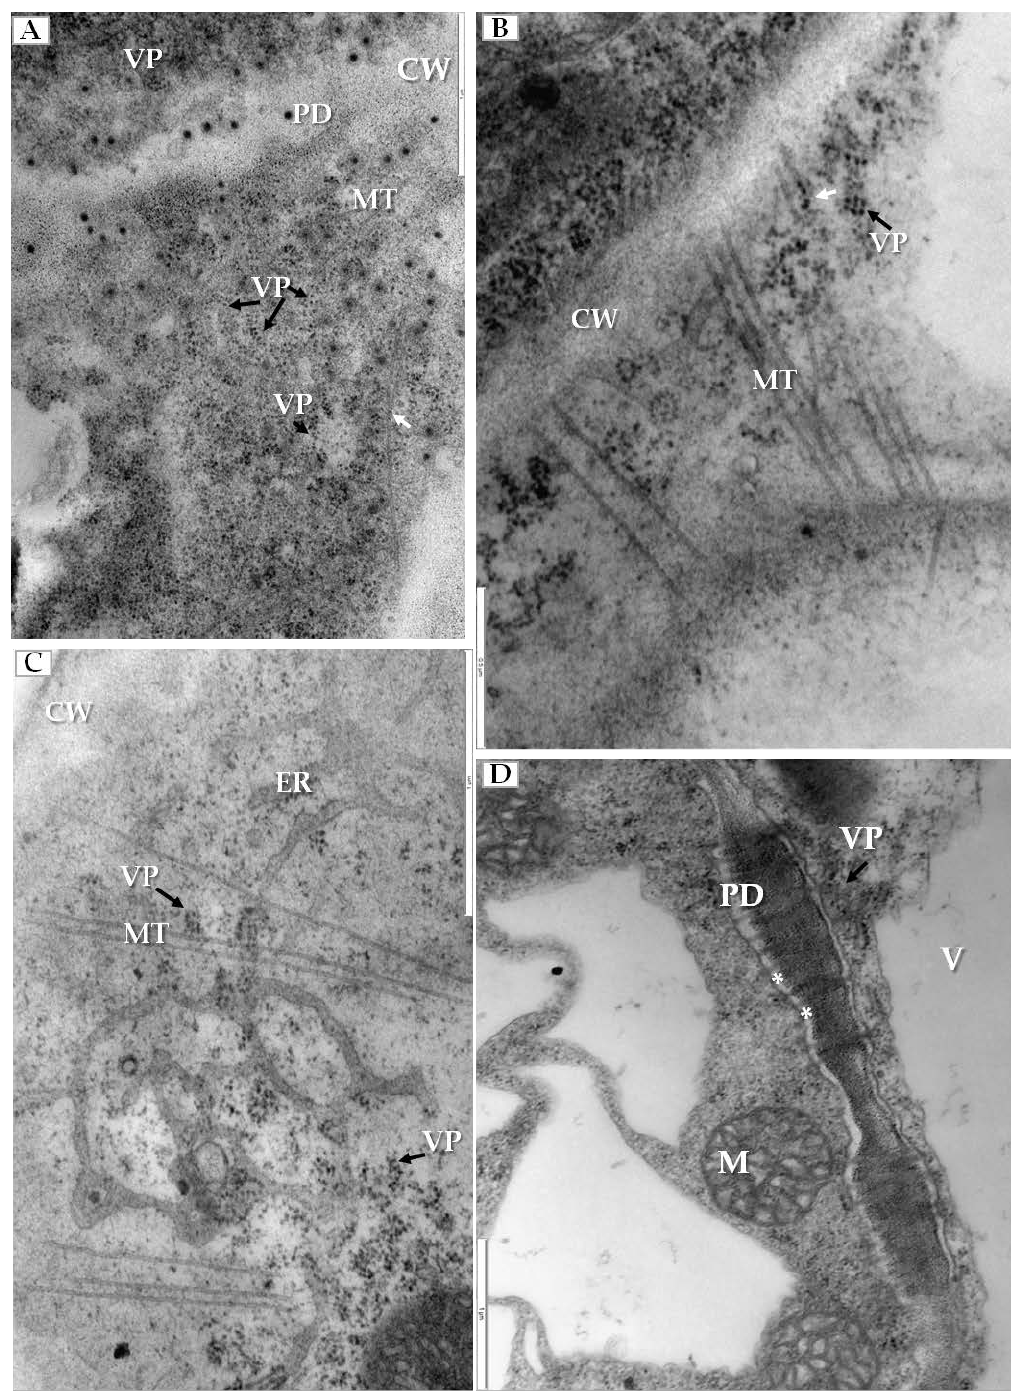
Figure 6. Tubular structures and changes in secondary plasmodesmata in PDV infected cucumber plants. ( A ) Phloem parenchyma cell with transverse sections of plasmodesmata. Viral particles are visible in cytoplasm (VP, black arrow) and in tubular structures directed to plasmodesmata (white arrow), Bar 1 µm; ( B ) Tubular structures with viral particles inside (white arrow). Tubular structures pass through cell walls of three cells. Viral particles (VP, black arrow) near plasmodesmata, Bar 0.5 µm; ( C ) PDV particles (VP, black arrow), tubular structures and enlarged endoplasmic reticulum cisterns in phloem parenchyma cell, Bar 1 µm; ( D ) Viral particles (VP, black arrow) near secondary plasmodesmata in phloem parenchyma cell. Moved plasmalemma (*) near secondary plamodesmata, Bar 1 µm. Abbreviations: CW—cell wall, PD—plasmodesmata, ER—endoplasmic reticulum, MT—movement protein induced tubular structures, VP, black arrow—viral particles, M—mitochondrion; V—vacuole.